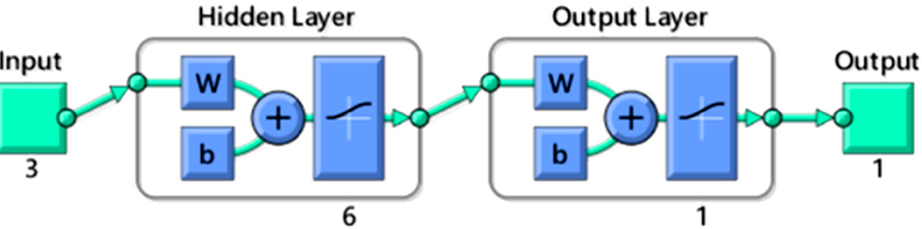
Figure 3. The optimal architecture of multilayer feed forward neural network. The network contains three inputs (reaction temperature, reaction time and enzyme amount), one hidden layer with six nodes and one output (molar conversion of 2-ethylhexyl ferulate). W means weight; b means basic input/output system (BIOS).